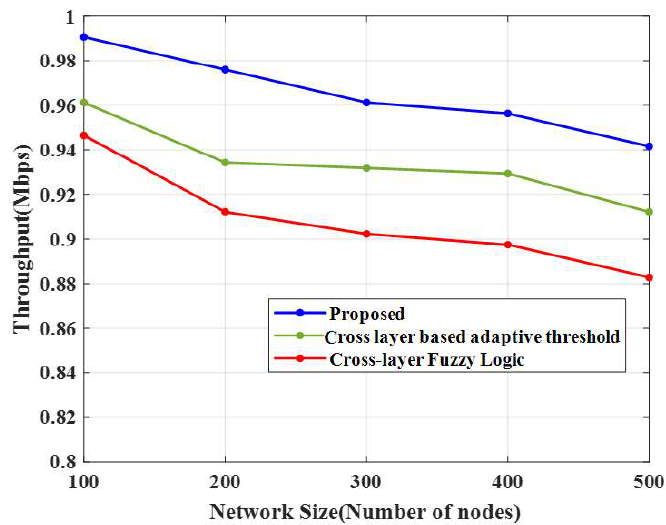
Figure 7. Throughput comparison.